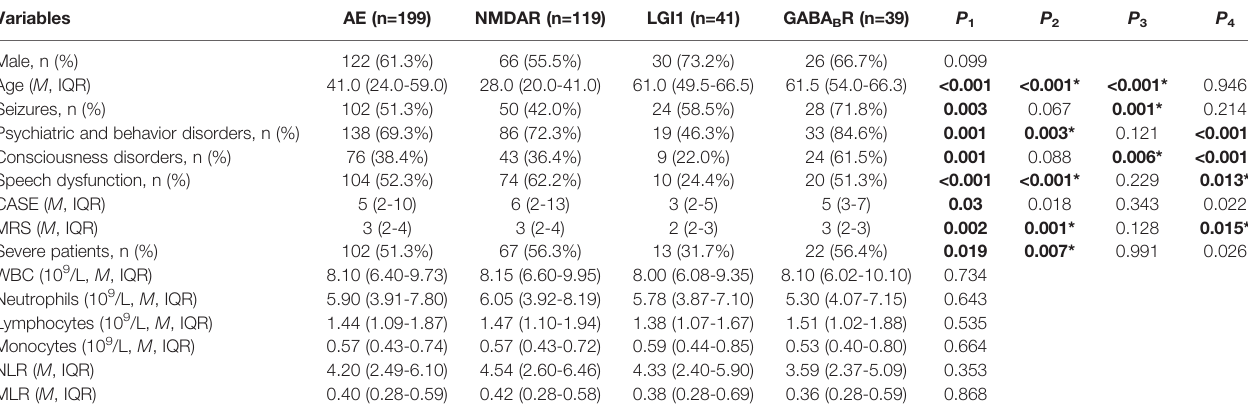
TABLE 1 | Clinical features and laboratory parameters of patients with AE.